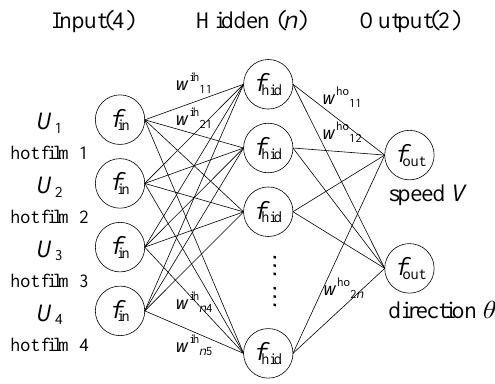
Figure 7. Structure of the neural network.